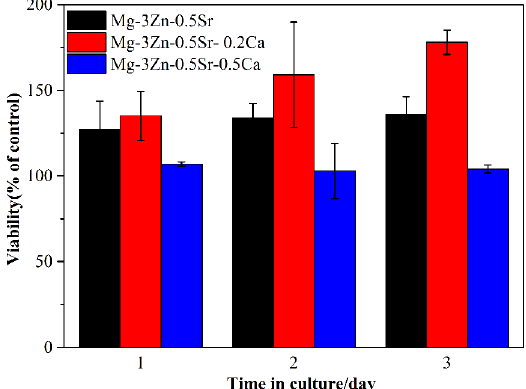
Figure 5. Mouse osteoblasts viability expressed as a percentage of the viability of cells in the control after 1, 2 and 3 days of culture in Mg-3Zn-0.5Sr-xCa alloys extraction media with 100% concentrations